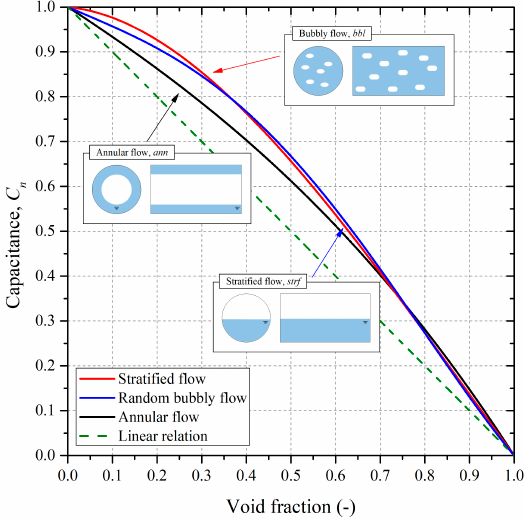
Figure 7. C– α curves for each representative flow pattern analyzed using FEM Figure 7. C– ⍺ curves for each representative flow pattern analyzed using FEM analysis.